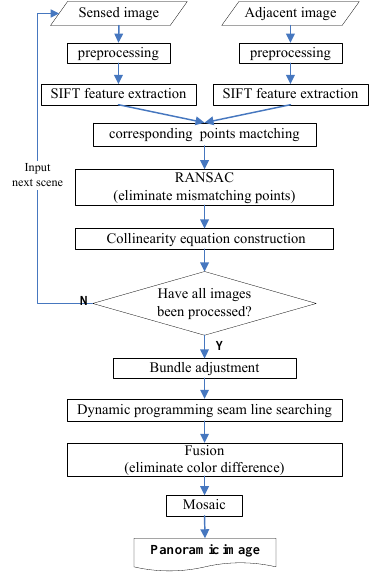
Figure 8. Flowchart of the UAV image